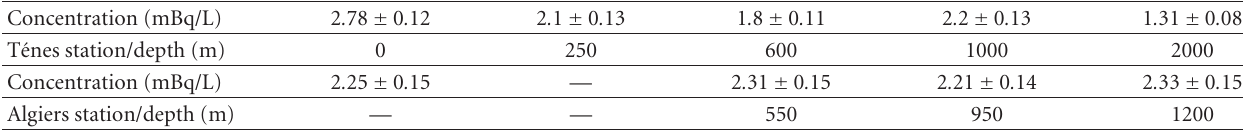
Table 2: Concentration of 137 Cs along water column in T´enes and Algiers